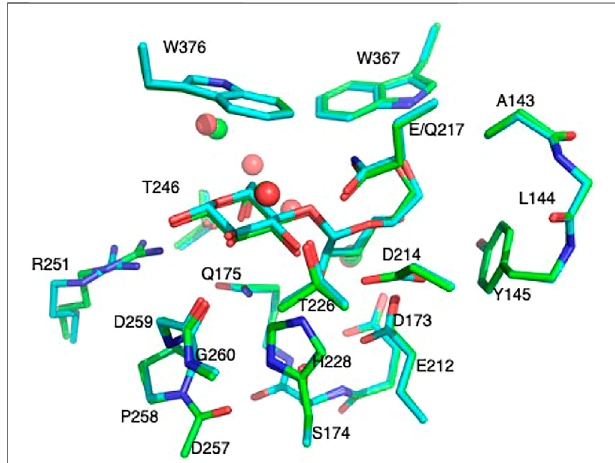
FIGURE 1 | Aligned 21-residue model of 8CEL Res21-E (green, waters in green sphere) and 23- residue model of 4C4C Res23-Q (cyan, waters in red